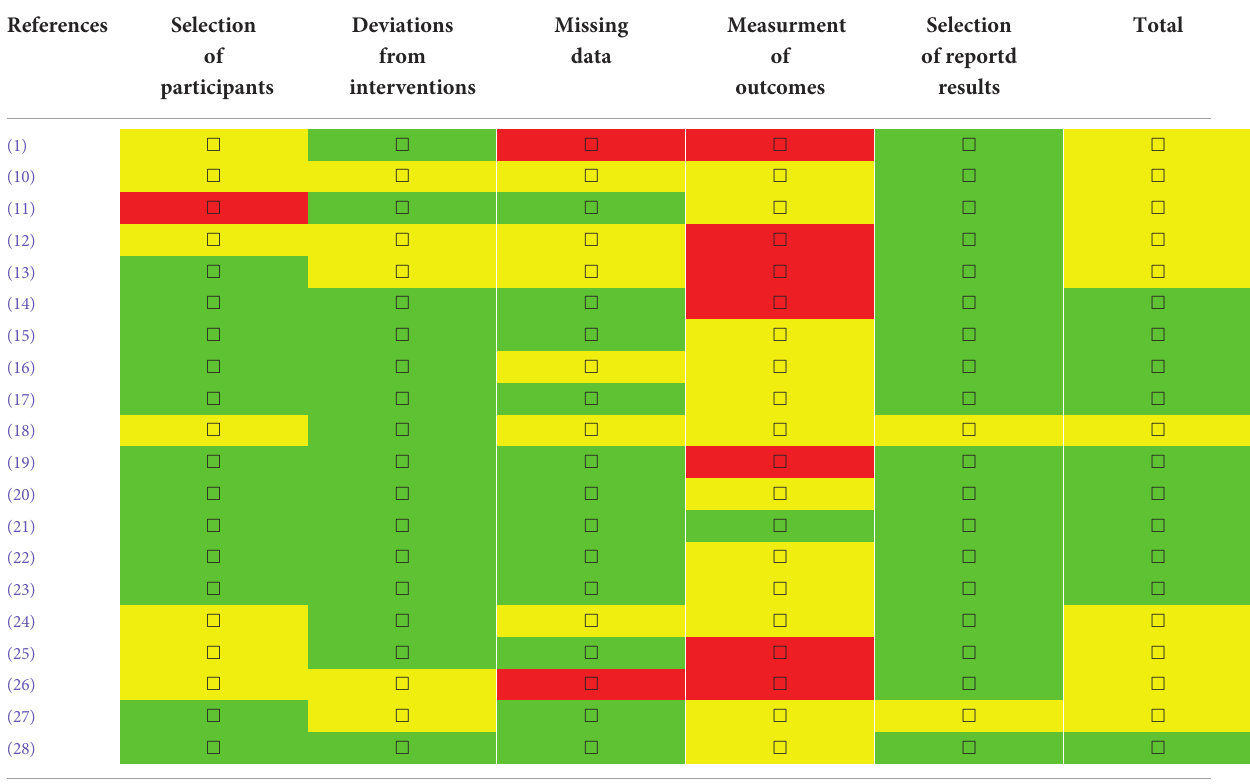
TABLE 2 Risk of bias